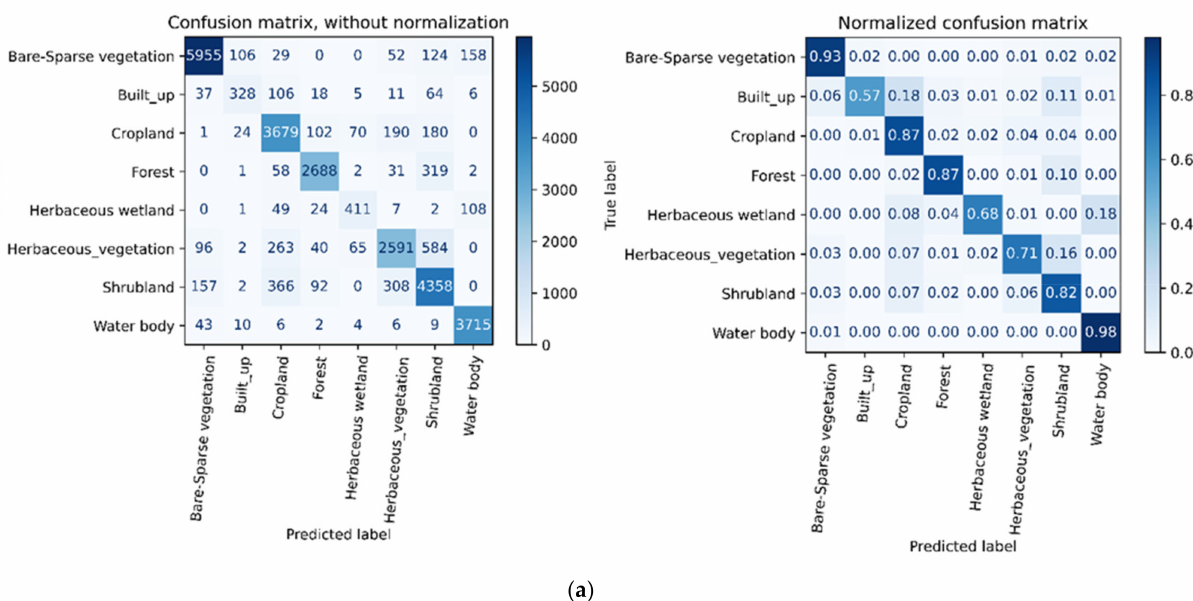
Figure 4. Land cover generated by the best RF model ( a ) and the best SVM model ( b ).